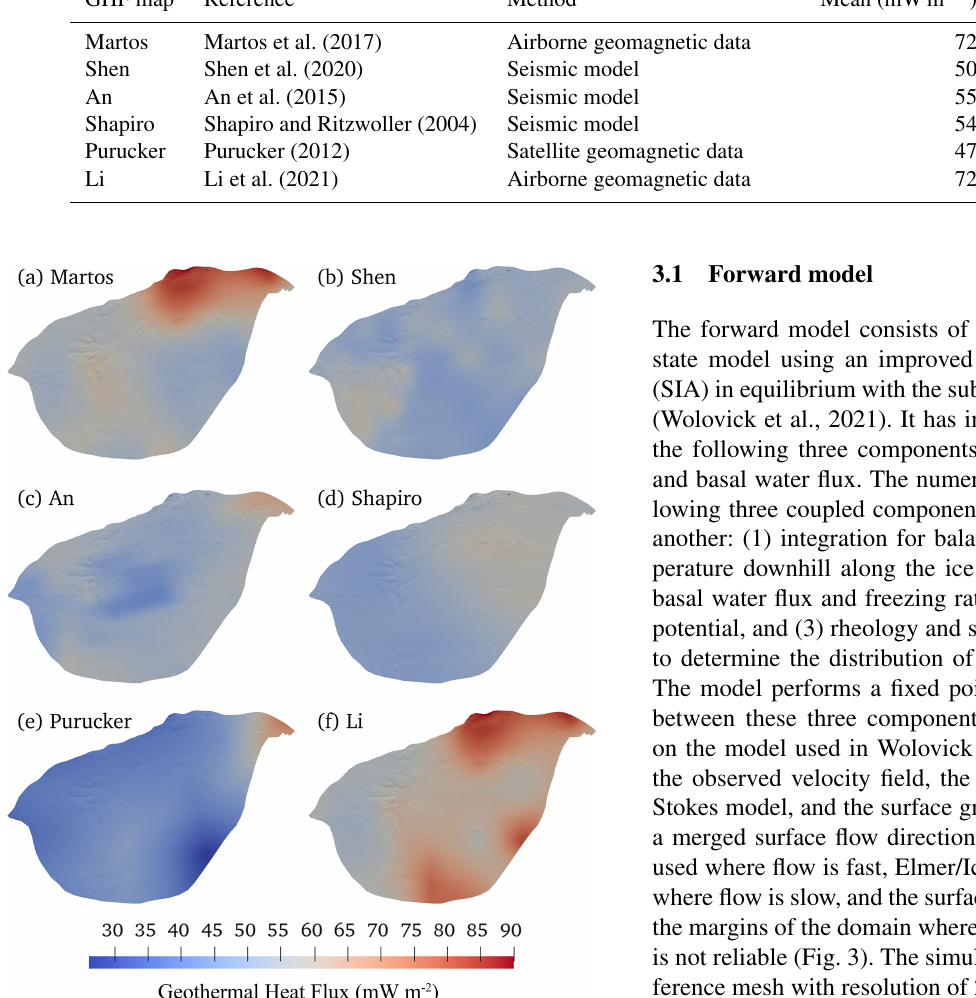
Figure 2. The spatial distribution of GHF over our domain, as de- scribed in Fig. 1. See Table 2 for the GHF map